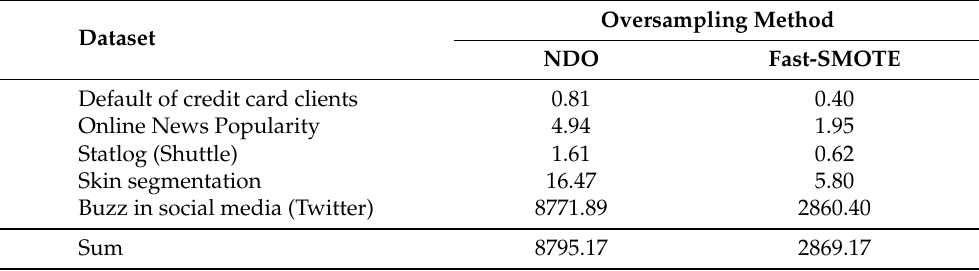
Table 7. Runtime in seconds spent by NDO and Fast-SMOTE on artificial datasets from Table 5. Dataset